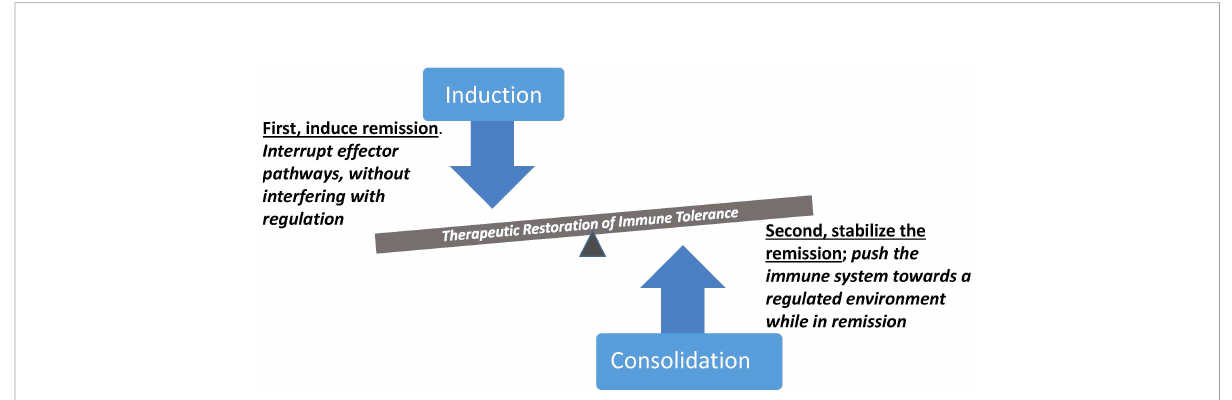
FIGURE 1 Synergistic contributions of immune therapies with complementary mechanistic targets. Induction of remission is initiated by abrogation of pathogenic effector cells and pathways, followed by consolidation therapy during remission to reinforce regulatory immune control. Selective therapeutic targeting is an important element of both steps, to avoid interfering with regulation during the inductive therapy and to avoid boosting pathogenic effector mechanisms during the pro-regulatory phase of treatment. Therapeutic outcomes with an immune regulatory dominance represent a form of immune tolerance with potential for sustained clinical bene fi